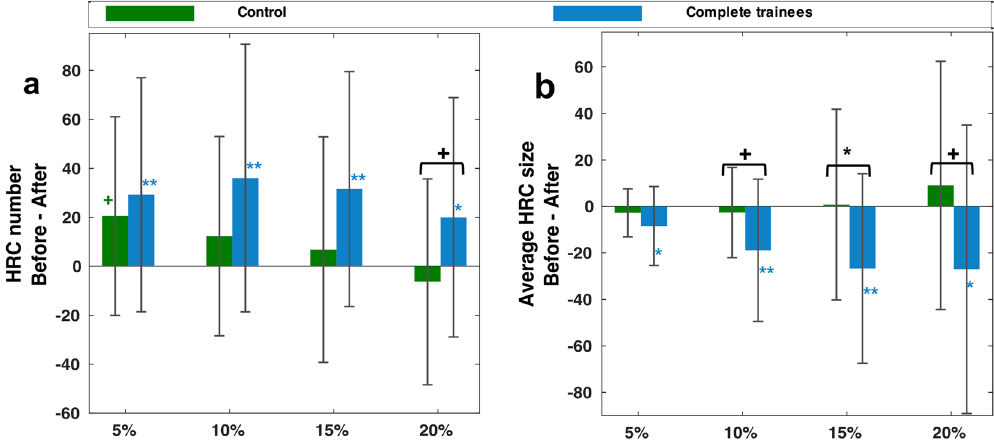
Figure 5. The before-after difference of ( a ) HRC number and ( b ) average HRC size in four different ReHo thresholds. The error bars indicate standard deviation. Horizontal square brackets in black indicate between- group comparison, while markers adjacent to the bars indicate within-group comparison ( ** p < 0.01, * p < 0.05, + p <